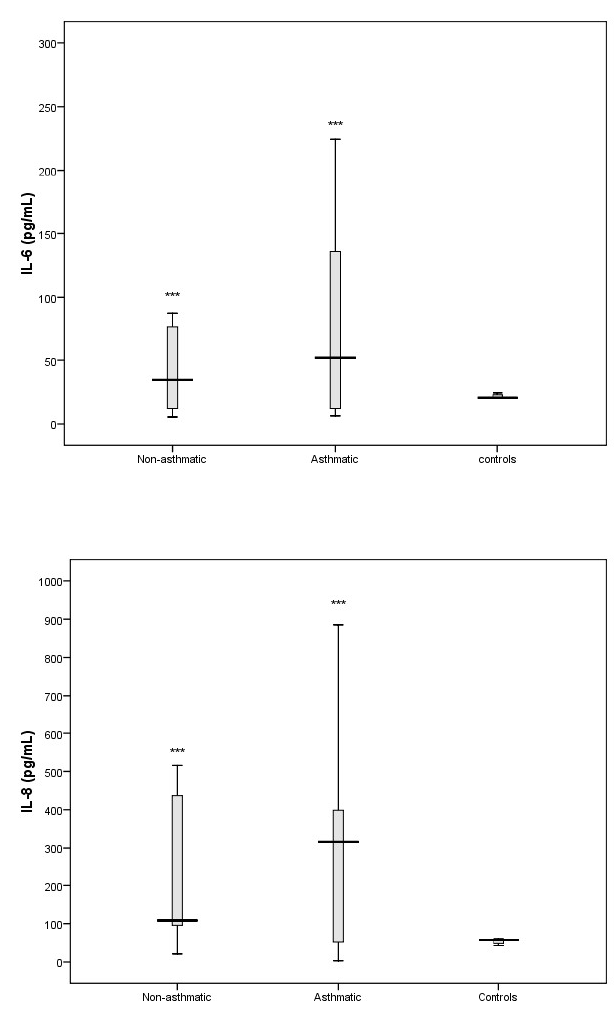
Figure 5. Levels of IL-6 and IL-8 in nasal secretions of non-respiratory disease controls ( n = 5), RV-C-infected patients with asthma ( n = 18 and without asthma. IL-6 and IL-8 were both significantly elevated both patient groups compared to controls. *** p < 0.001.